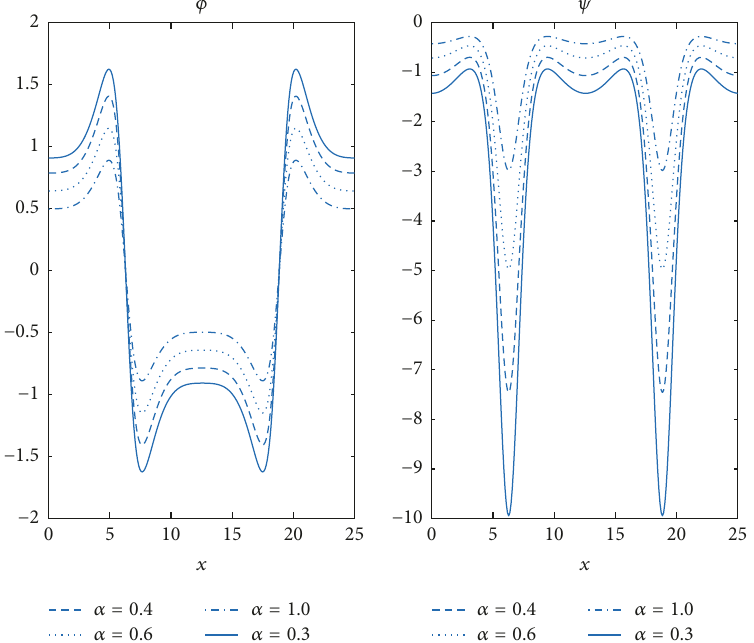
Figure 18: Comparison of periodic travelling wave solutions of the SBO system for different values of the parameter 𝛼